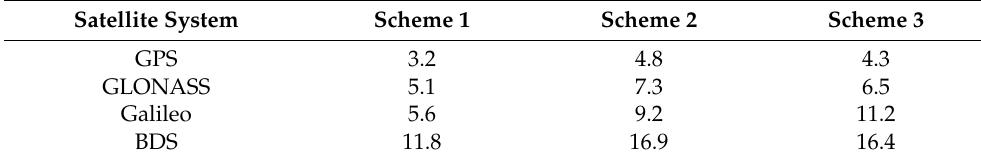
Table 8. Statistics of the accuracy of ultra-rapid predicted orbit (cm).